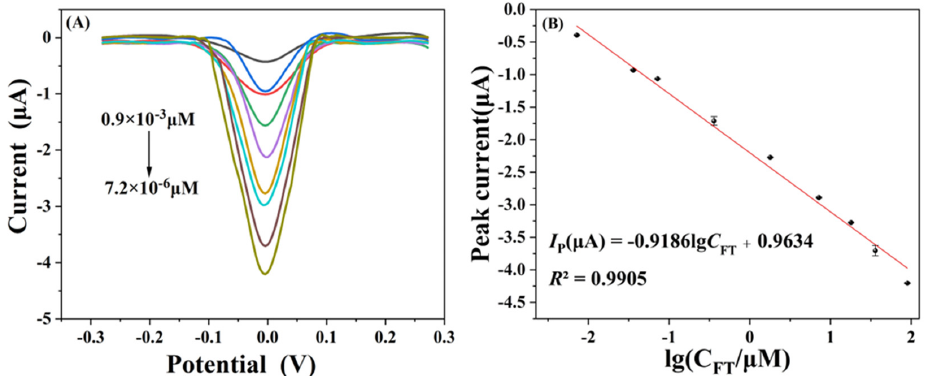
Figure 4. ( A ) Differential pulse voltammogram of different FT concentrations at NH 2 − MIL − 125(Ti)/RGO/GCE. ( B ) Calibration curve between peak current ( μ A) and the logarithm of FT concentrations ( μ M) ( n = 3).